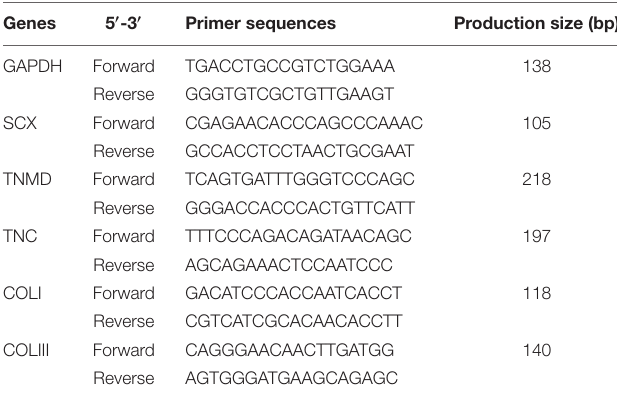
TABLE 1 | List of primer sequences utilized for real-time Polymerase Chain